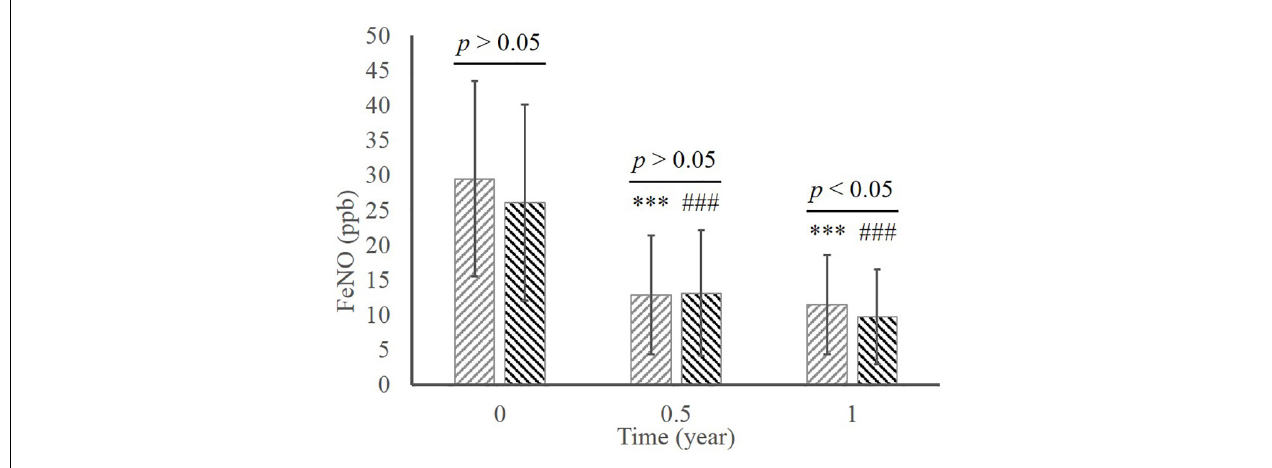
FIGURE 4 | The comparison of FeNO between the MD group and the ED group. ∗∗∗ , p < 0.001, significant difference in the MD group compared to baseline; ### , p < 0.001, significant difference in the ED group compared to baseline. MD, morning dosing; ED, evening dosing; FeNO, fractional exhaled nitric